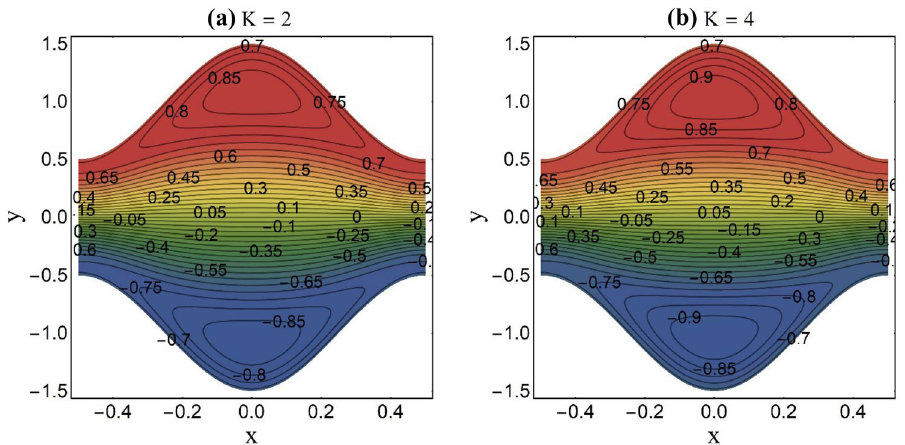
Figure 11. Streamlines pattern at fixed Ha = 1 and U HS = − 1.